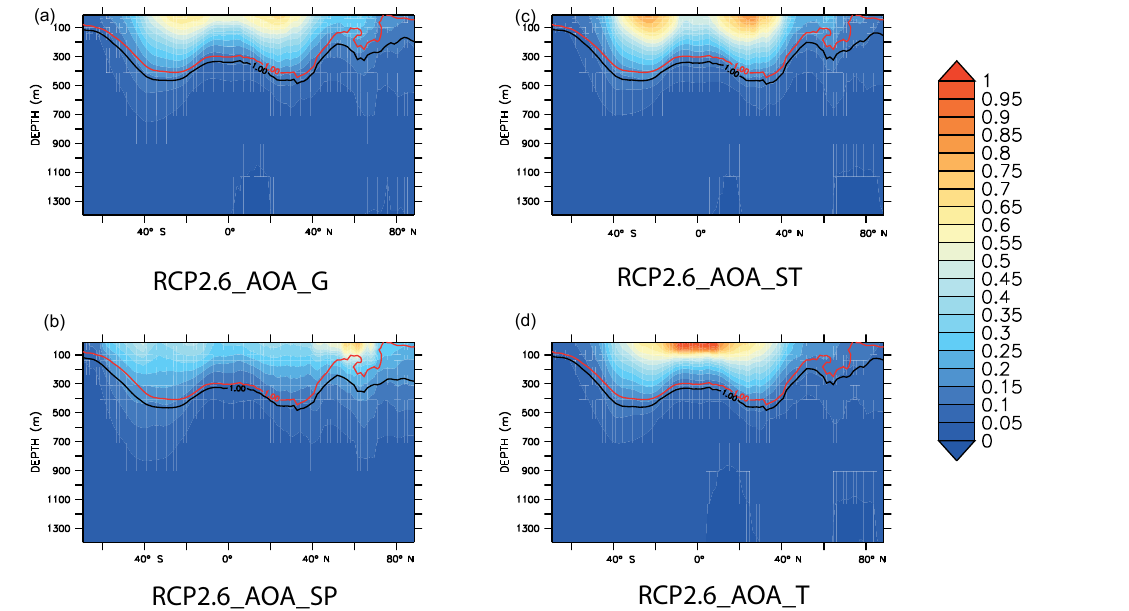
Figure 14. The zonal mean differences in aragonite saturation state in 2090 (mean; 2081–2100), associated with global and regional AOA under RCP2.6, relative to RCP2.6 with no AOA. Contoured on each map are the values of aragonite saturation state of 1; please see the text for more explanation. The red contours represent RCP2.6 without AOA and the black contours represent RCP2.6 with AOA for each